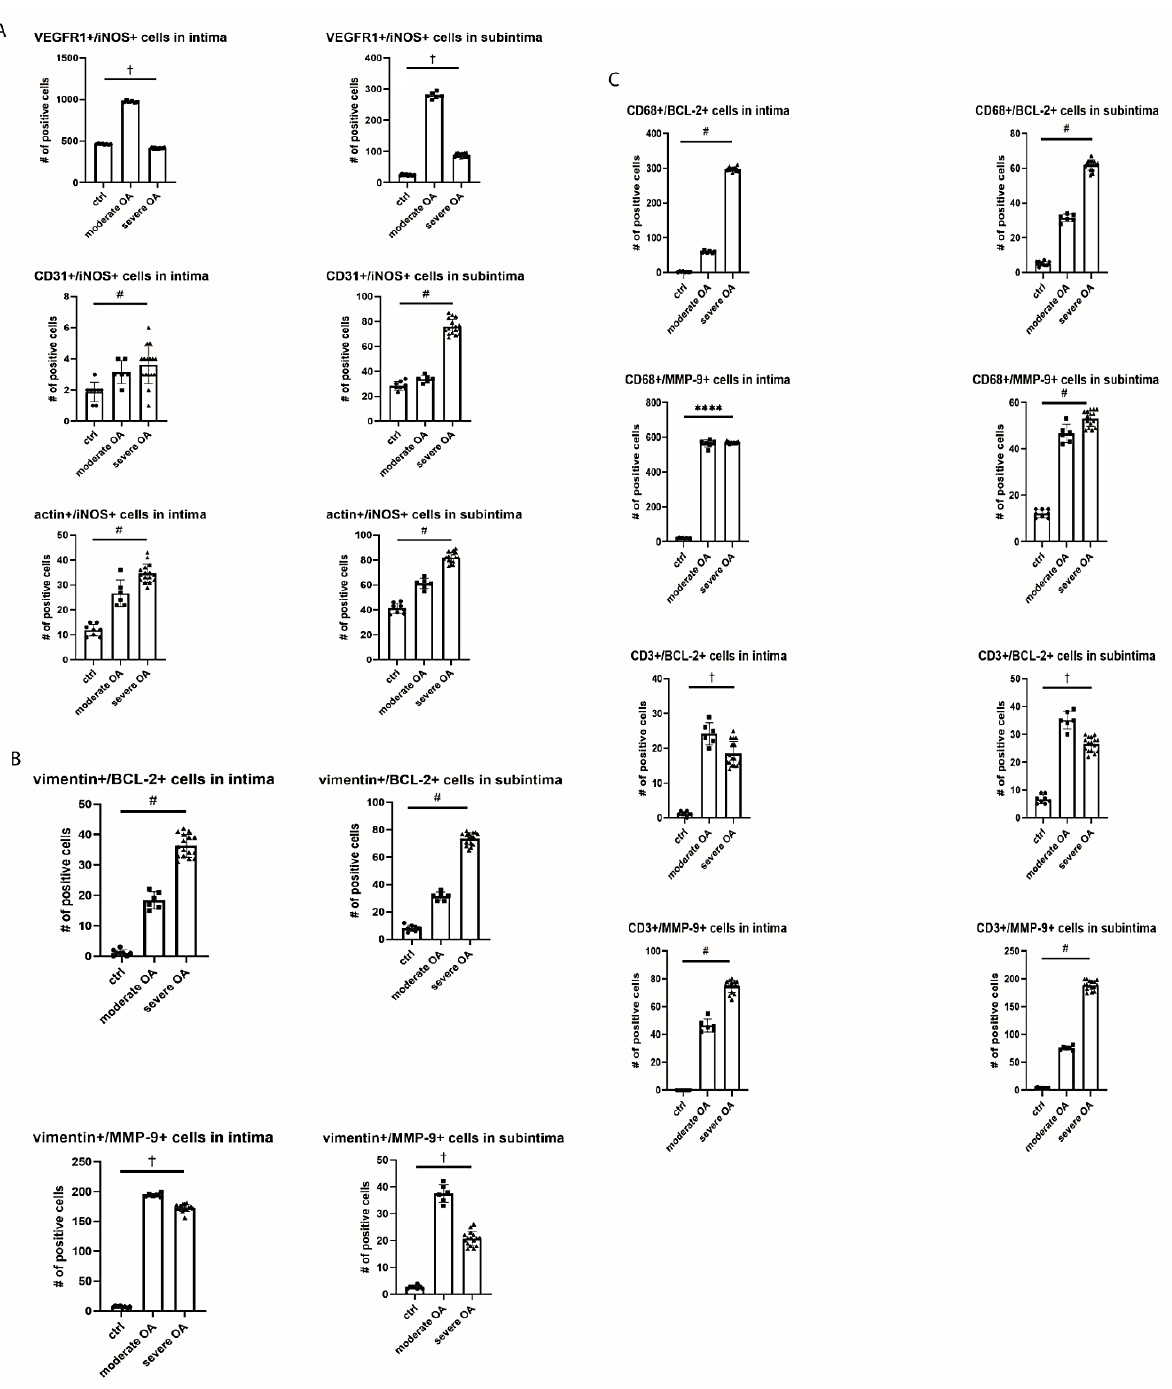
Figure 6. Expression of VEGFR1, CD31, BCL2 and MMP-9 in vascular cells ( A ), fibroblast like cells ( B ) and macrophages and T cells ( C ) in synovial tissue of OA patients. Legend: osteoarthritis (OA); ****, p < 0.0001 for ANOVA; #, p < 0.05 for the test for linear trend; † p < 0.05 for the test for parabolic (quadratic) trend.